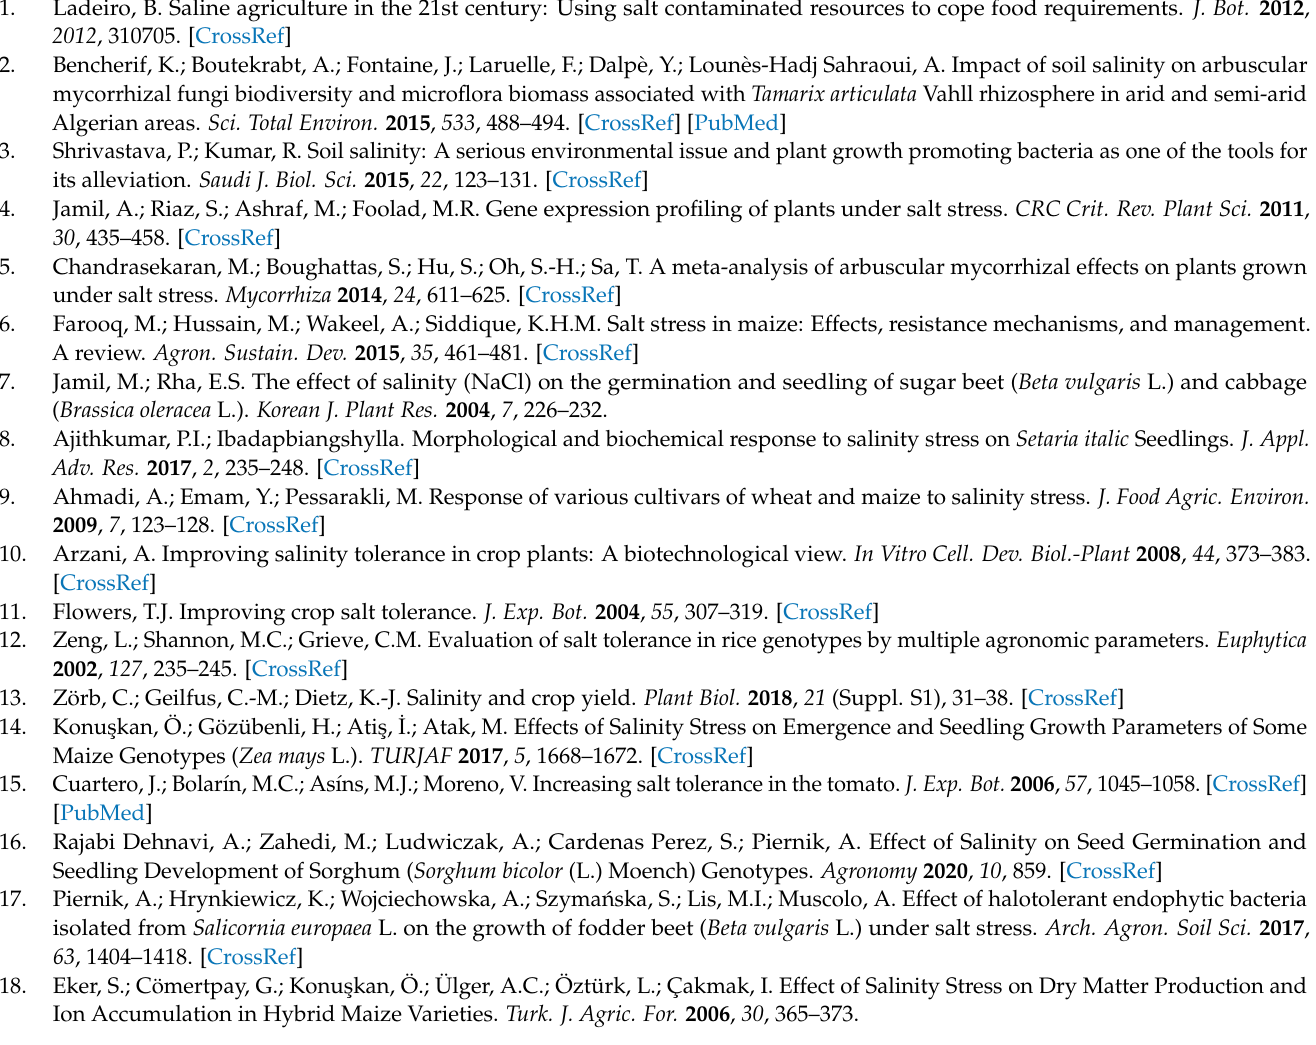
Table S2: Results of discriminant analysis, forward selection and Monte Carlo permutation